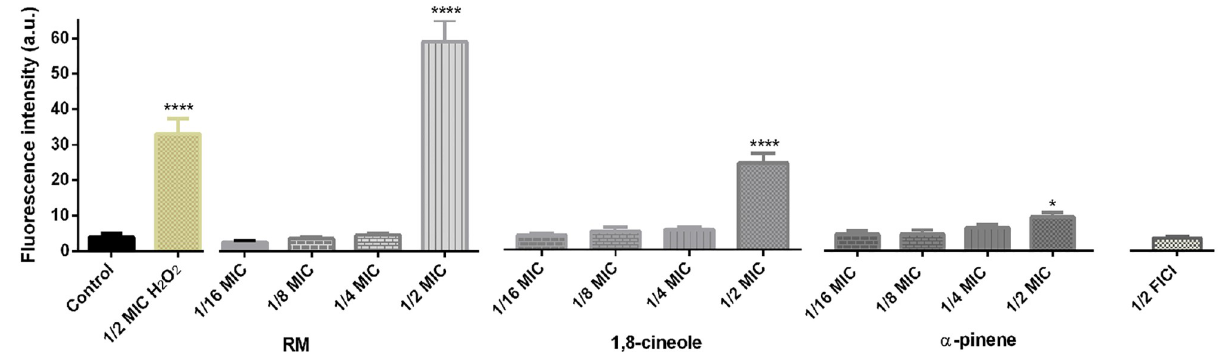
Fig 5. Impact of RM oil and its components on C . albicans intracellular ROS accumulation. Bar graphs of intracellular ROS in untreated C . albicans RBY1132, and those treated with RM oil, 1,8-cineole, α -pinene and H 2 O 2 (25 mM). Fluorescence intensity was measured in a plate reader ( λ ex = 485 nm; λ em = 528 nm, gain 35) and data are presented as the mean ± SEM of three biological replicates for which statistical significance ( ���� , p < 0.0001; � , p < 0.05) was evaluated by a one-way ANOVA, followed by Dunnett’s multiple comparison of each condition versus